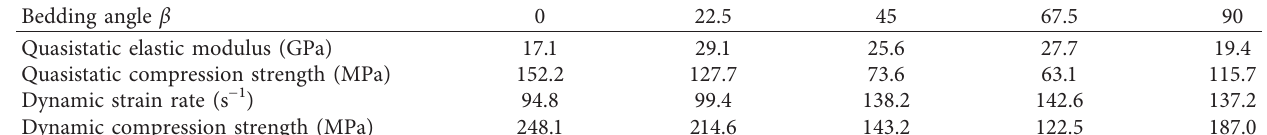
Table 1: Quasistatic and dynamic mechanical properties of layered phyllite.